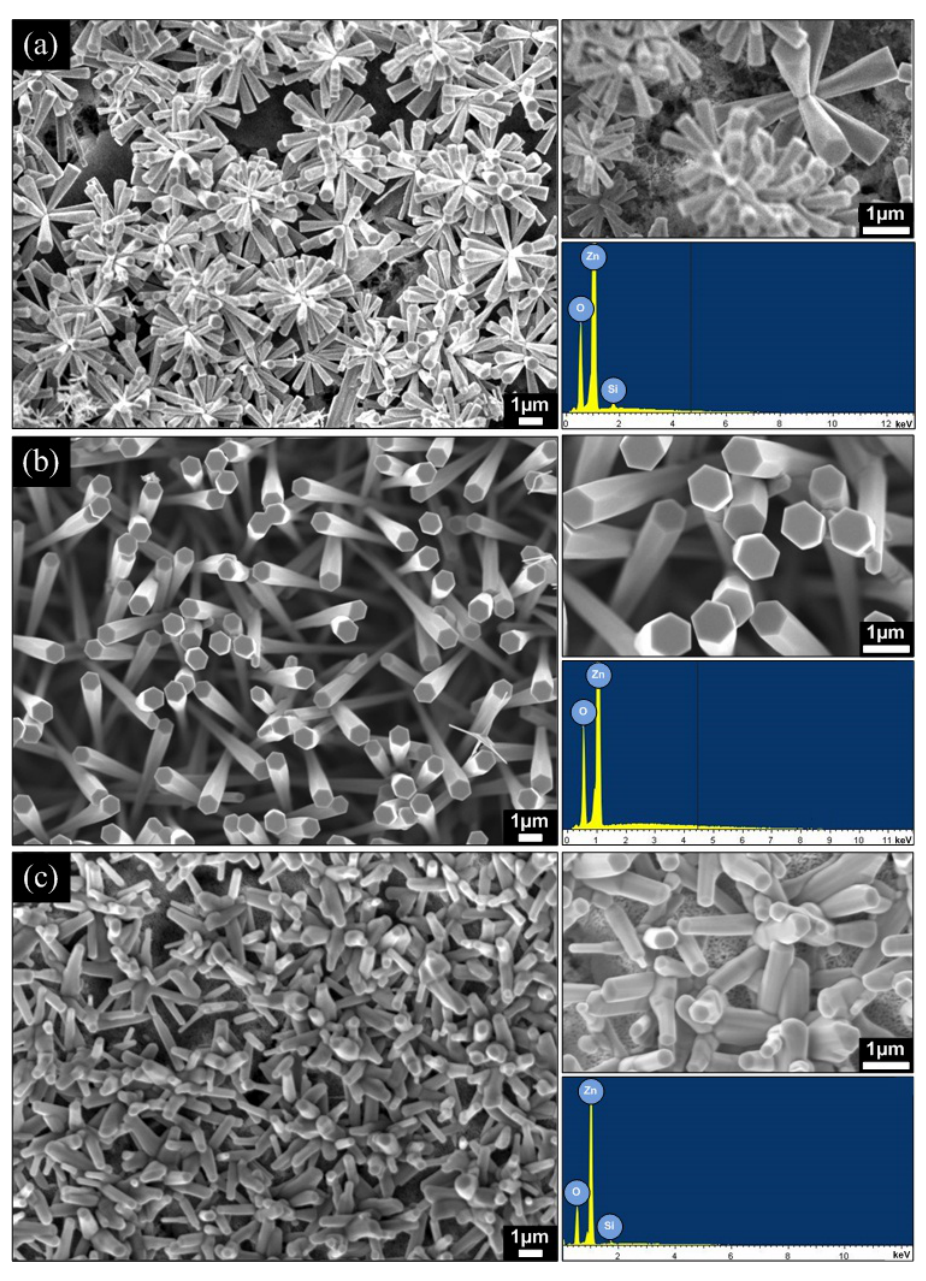
Figure 4. FESEM images, and energy dispersive X-ray spectroscopy (EDS) spectra of ZnO nanorods grown on PS substrates at different growth temperatures of ( a ) 600 °C; ( b ) 800 °C and ( c ) 1000